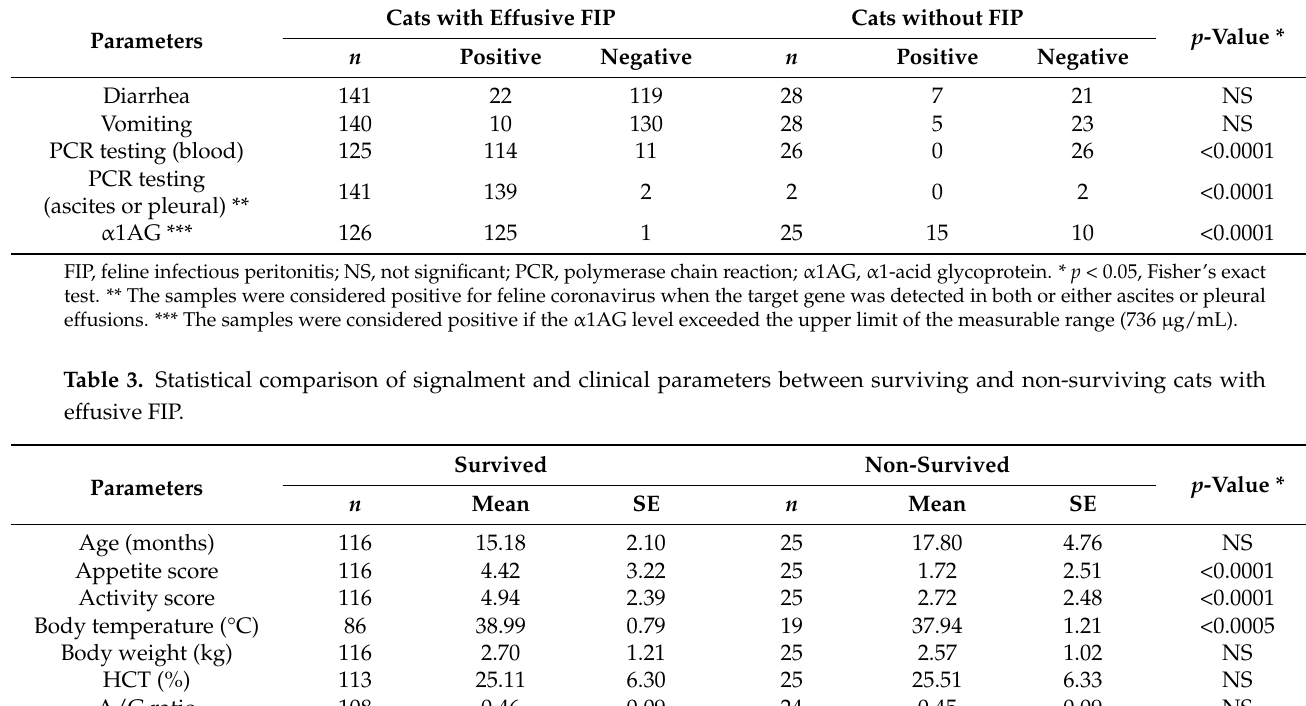
Table 4. Statistical comparison of categorical parameters between surviving and non-surviving cats with effusive FIP. Parameters